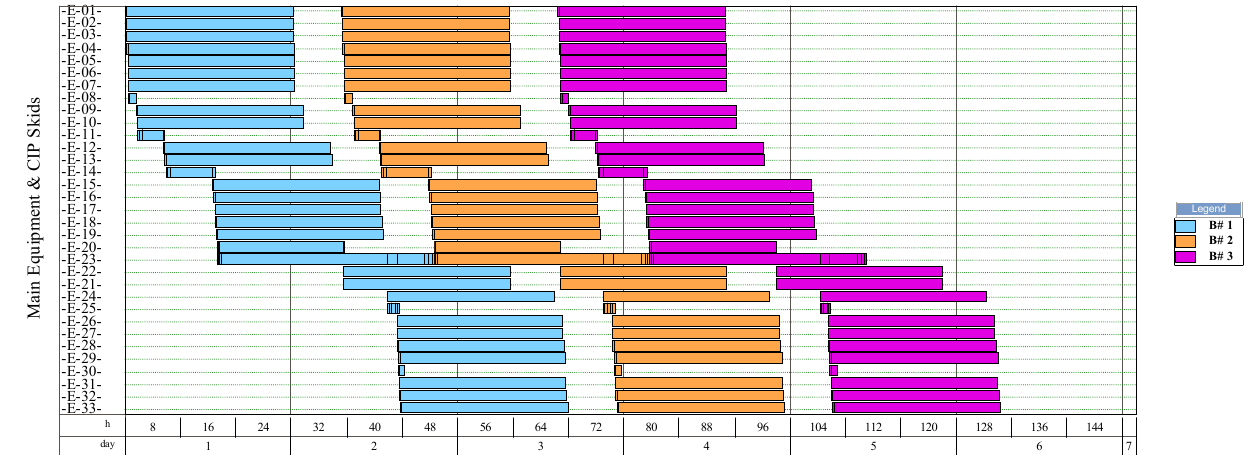
Figure 9. Equipment occupancy chart of the process for producing single-cell protein from rejected unripe plantain fruits. B: batch; CIP: cleaning-in-place. The labels of the equipment units are shown in Figure 5.